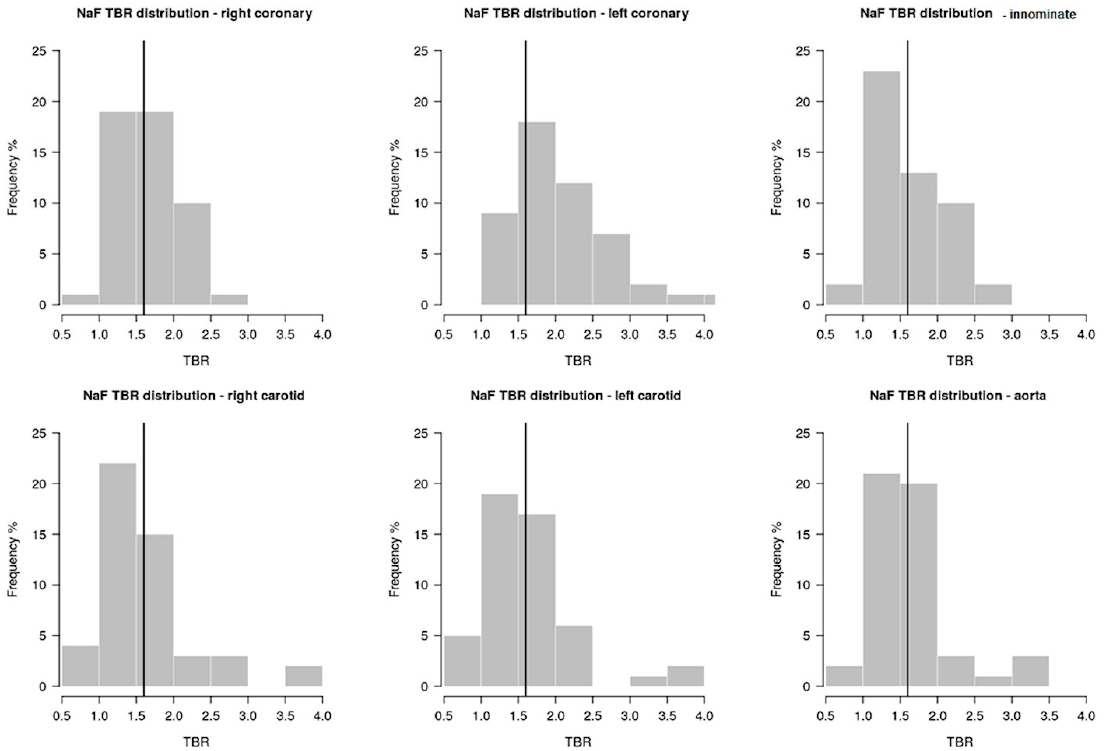
Figure 3. Proportional distribution of 18 F-Sodium Fluoride uptake assessed as target-to-background ratio in each arterial territory. The vertical line identifies a target-to-background ratio of 1.6 that was chosen as a threshold for high 18 F-Sodium Fluoride uptake.